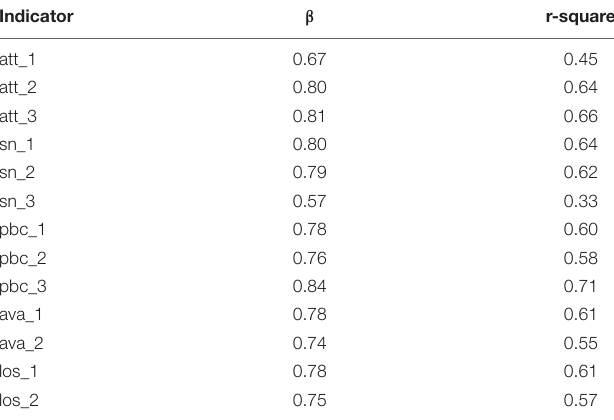
TABLE 3 | Parameter estimates and r-square.